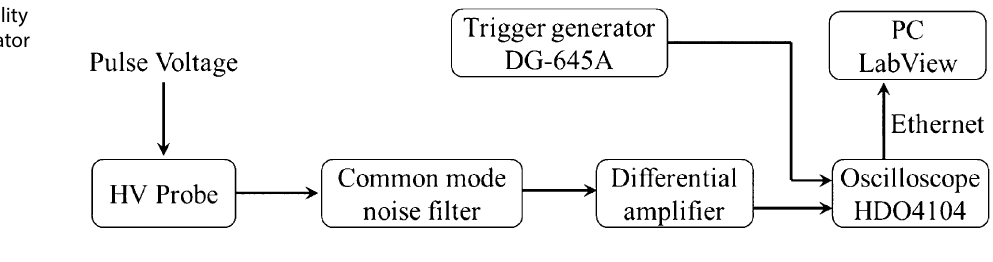
Fig. 9 Test results of RF Amplitude stability for pulse klystron. Running amplitude standard deviation of 797 consecutive pulses measured with oscilloscope ( a ) and Running amplitude standard